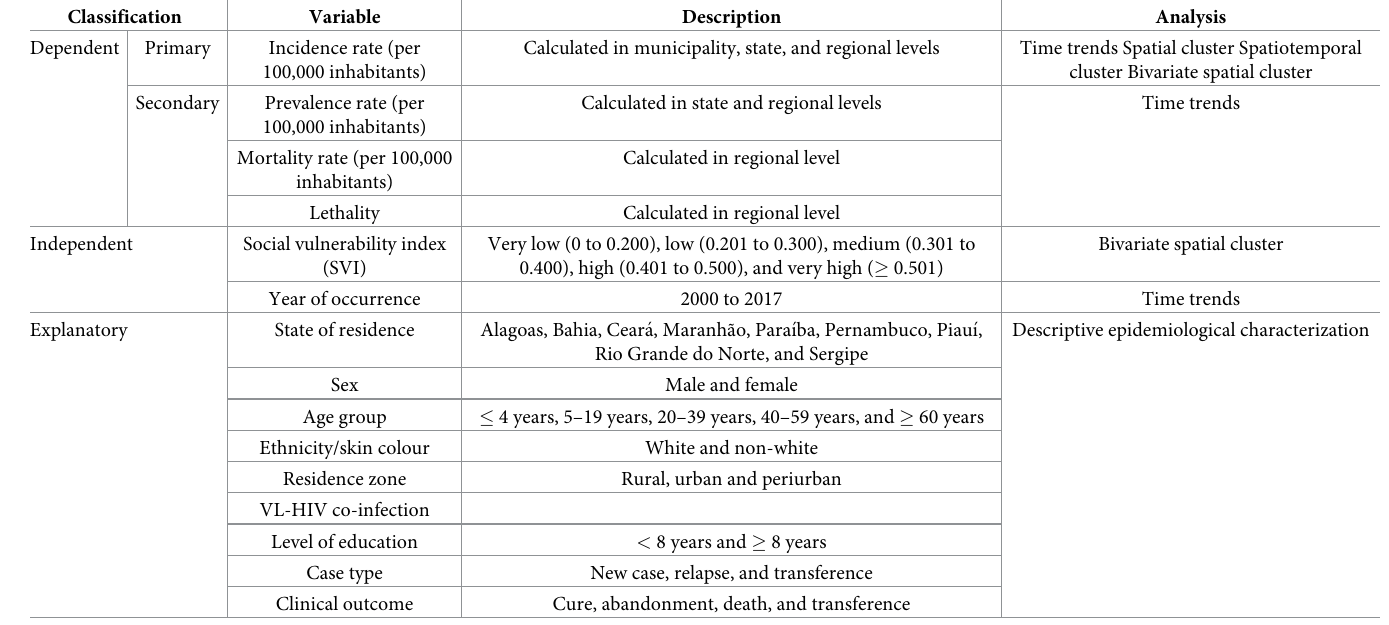
Table 1. Description of study